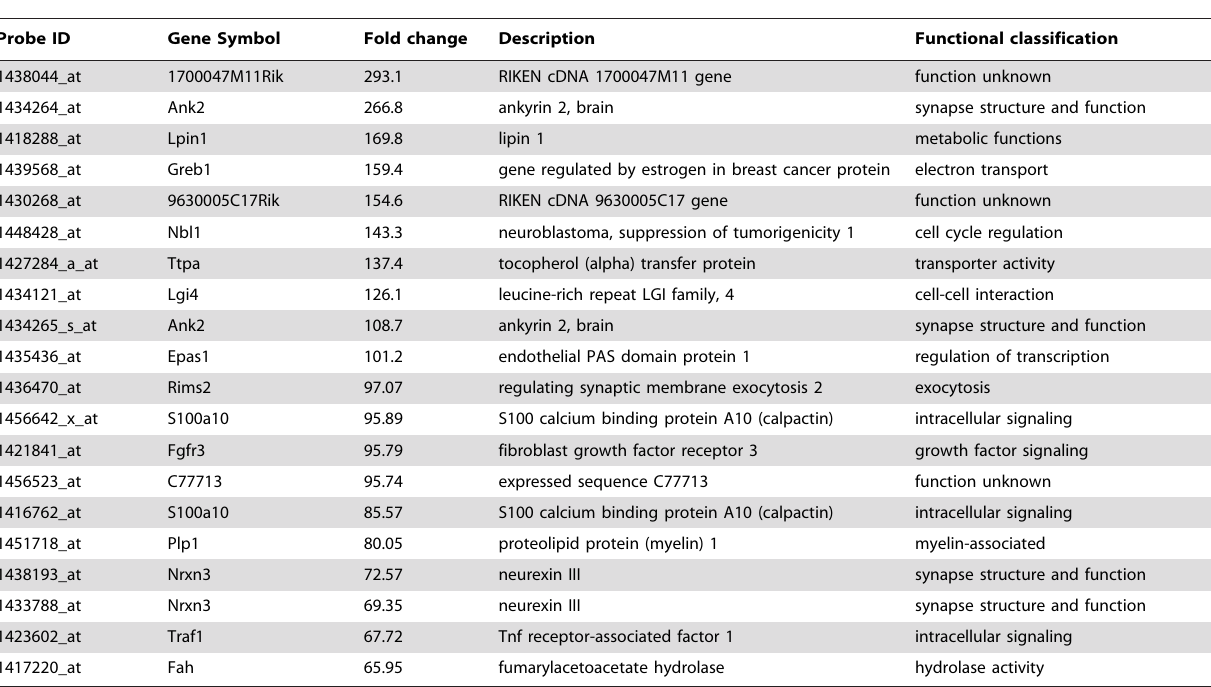
Table 3. Top 20 probe-sets showing largest fold-difference in expression (P30 . P6).